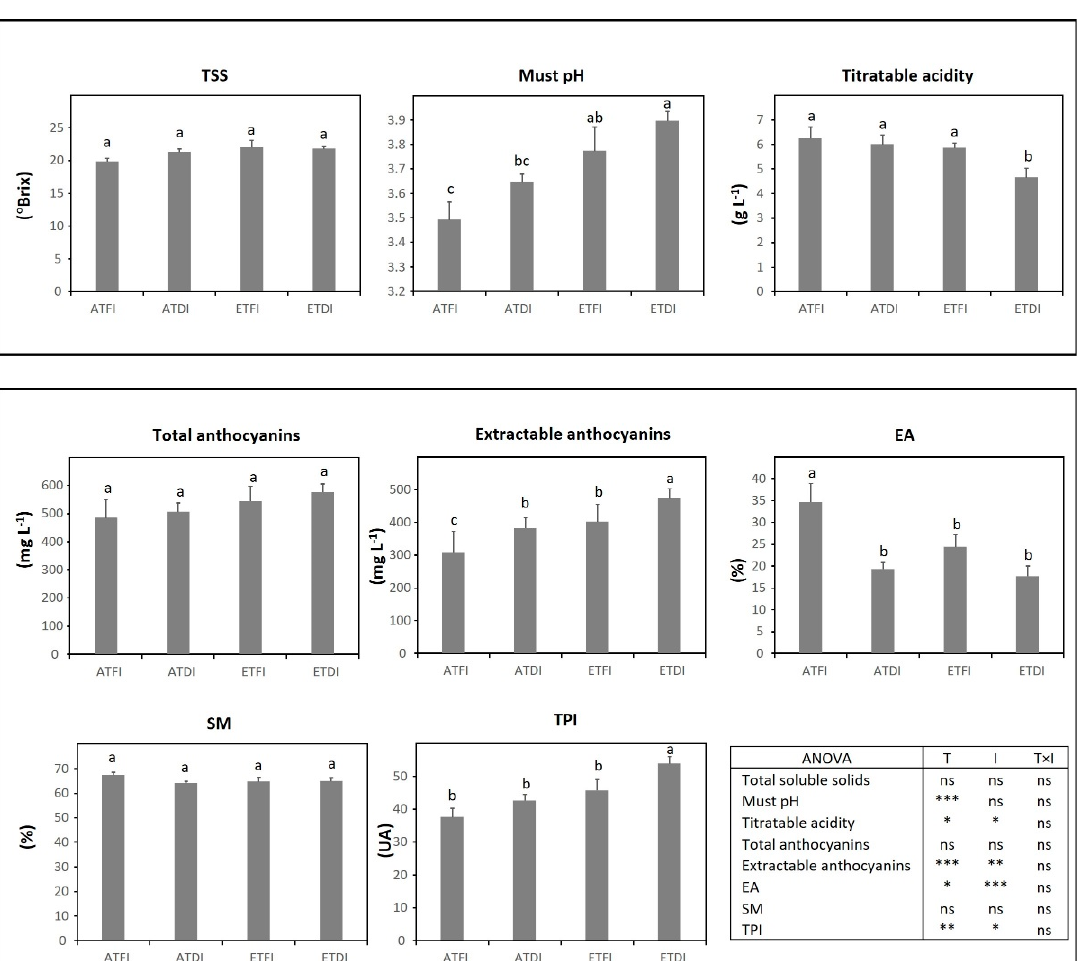
Figure 5. Grape technological and phenolic maturity assessed at harvest in fruit-bearing cuttings of Graciano (GRA) grown either at ambient (AT) or elevated temperature (ET) and subjected to different irrigation regimes (FI, full irrigation; DI, deficit irrigation). Values are means ± S.E. ( n = 5). Bars topped by the same letter do not differ significantly (p > 0.05) according to Duncan’s test. Significance of the analysis of variance (ANOVA): * p < 0.05; ** p ≤ 0.01; *** p ≤ 0.001; ns, not significant ( p ≥ 0.05). TSS, total soluble solids; TPI, total polyphenol index; EA, cellular extractability of anthocyanins; SM, seed maturity; AU, absorbance units.